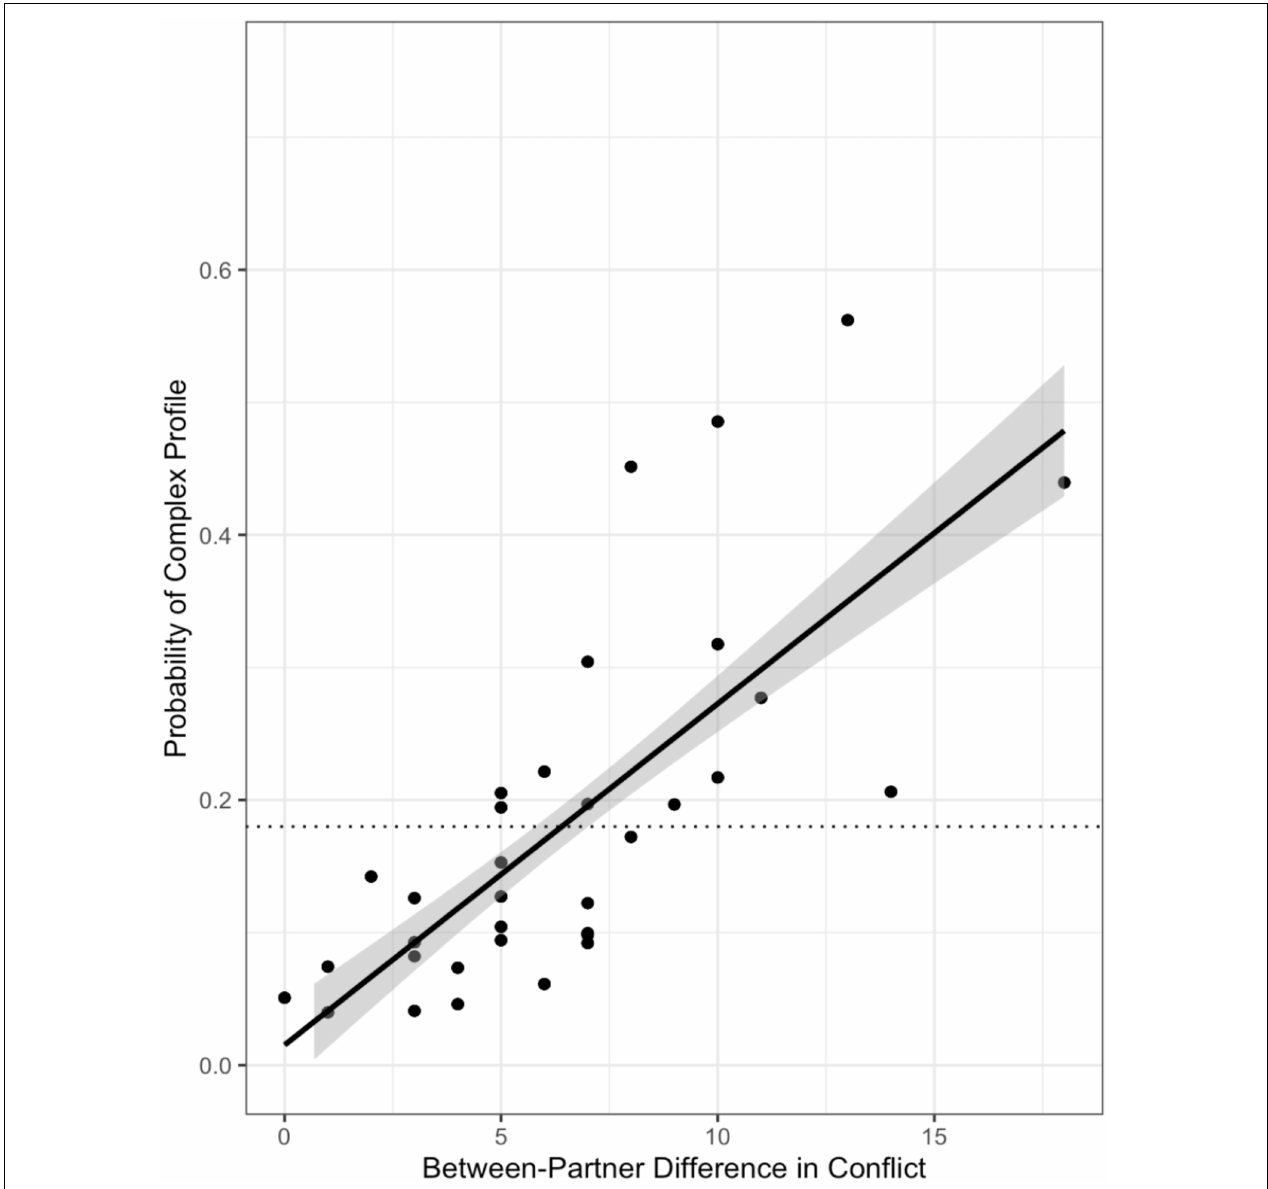
FIGURE 3 | The main effect of between-partner differences in conflict across contexts. The dotted line shows the unconditional probability of being in the complex profile as a reference point. Larger between-partner differences in conflict were associated with a higher probability of being in the complex profile across